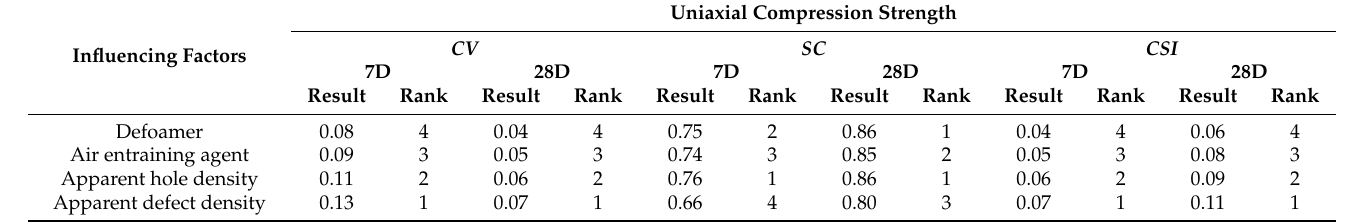
Table 9. Comparison of fuzzy evaluation value of influencing factors of uniaxial compression strength of